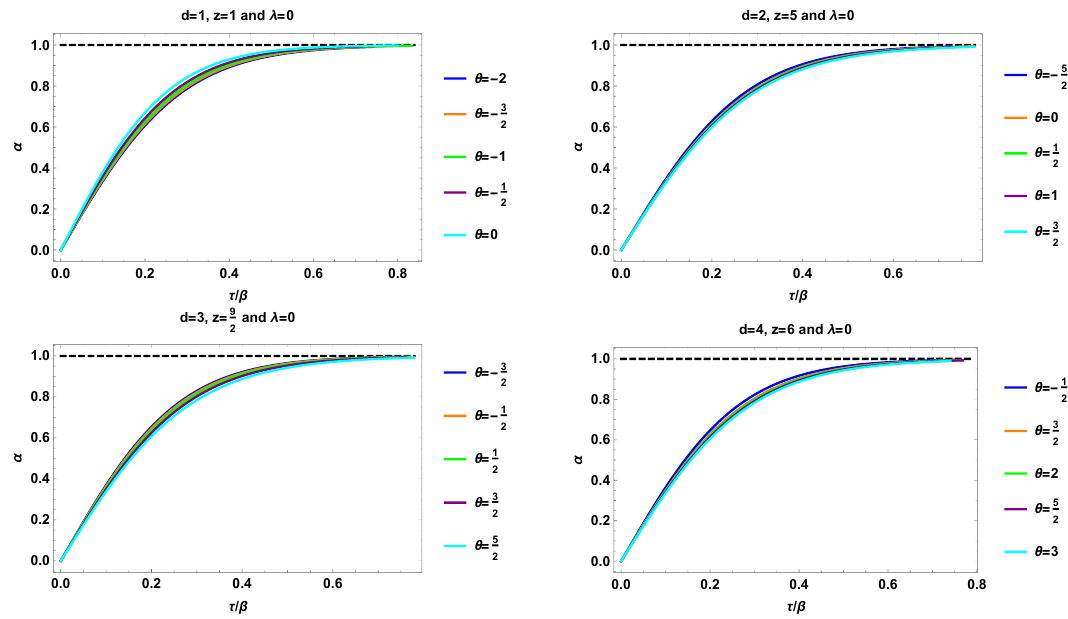
Figure 4 . The normalized growth rate α as a function of τ/β for λ = 0 and different values of d , θ and z : Top Left ) d = 1 and z = 1 , Top Right ) d = 2 and z = 5 , Down Left ) d = 3 and z = 9 Right ) d = 4 and z = 6 . We set L = r h = r F = 1